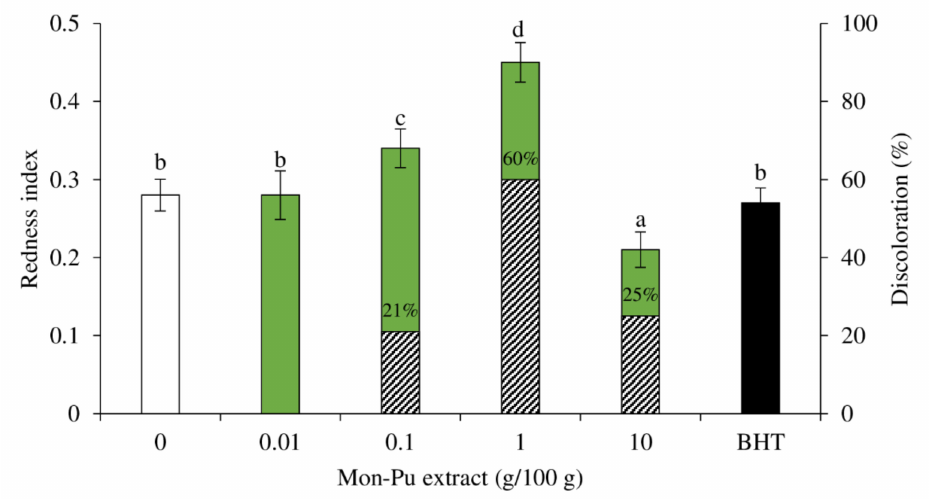
Figure 5. Effect of Mon-Pu leaf extract (MPE) on redness index and percentage discoloration (pattern fill) of a cooked sausage model system (SMS). Butylated hydroxyl toluene (BHT) at 0.003% was used to compare. The percentage discoloration was calculated relative to the control without MEP and BHT. Bars represent the standard deviations from triplicate determinations. Different letters indicate the significant differences ( p <